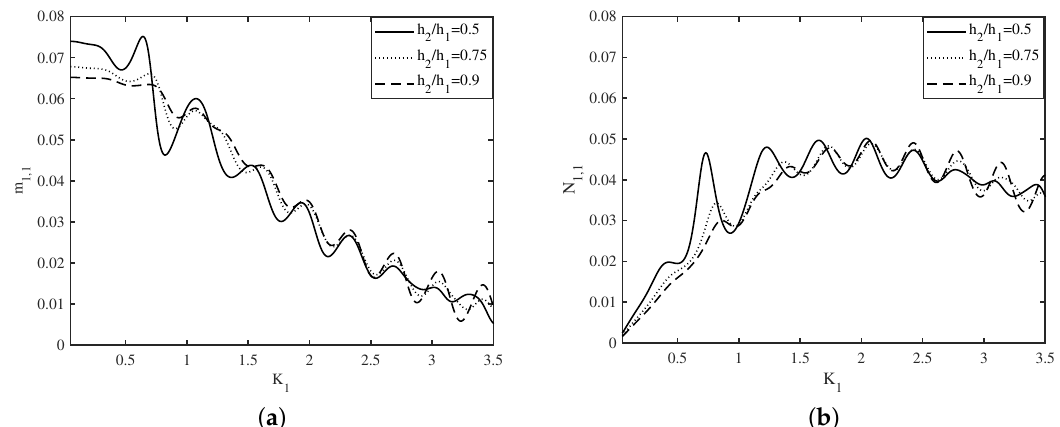
Figure 5 delineates (a) the added mass m 1,1 and (b) the damping coefficient N 1,1 versus the wavenumber K 1 as a function of depth ratio h 2 / h 1 . The overall patterns of m 1,1 and N 1,1 as a function of K 1 are similar in nature as those of Figures 3 and 4. Moreover, it is observed that the oscillatory pattern in the added mass m 1,1 and damping coefficient N 1,1 increases for lower values of the depth ratio h 2 / h 1 . This is obvious as for lower values of the depth ratio h 2 / h 1 , the gap between the free surface and the bottom reduces and as a result, the effect of bottom on waves radiation becomes stronger.